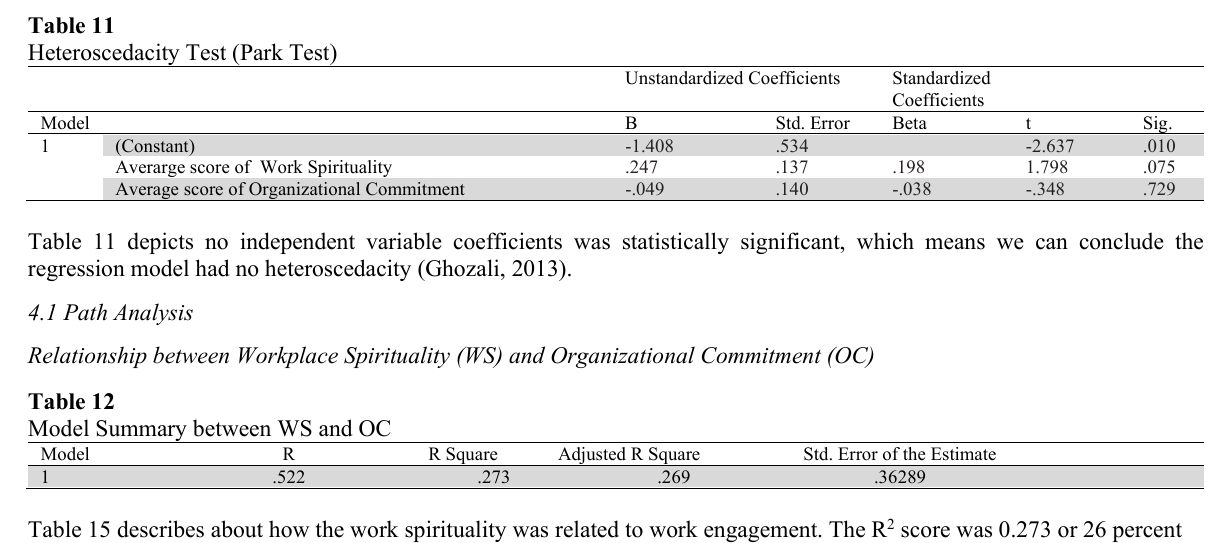
Table 15 describes about how the work spirituality was related to work engagement. The R 2 score was 0.273 or 26 percent work spirituality was related with work engagement and the rest or 73 percent was decided by other variable that were not discussed in this research.